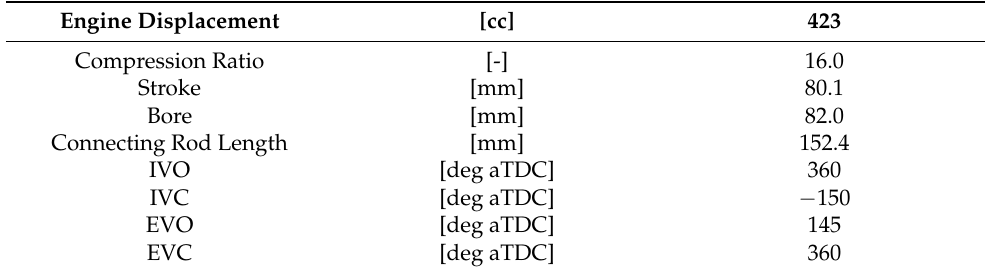
Table 1. Engine geometry and valve timings.